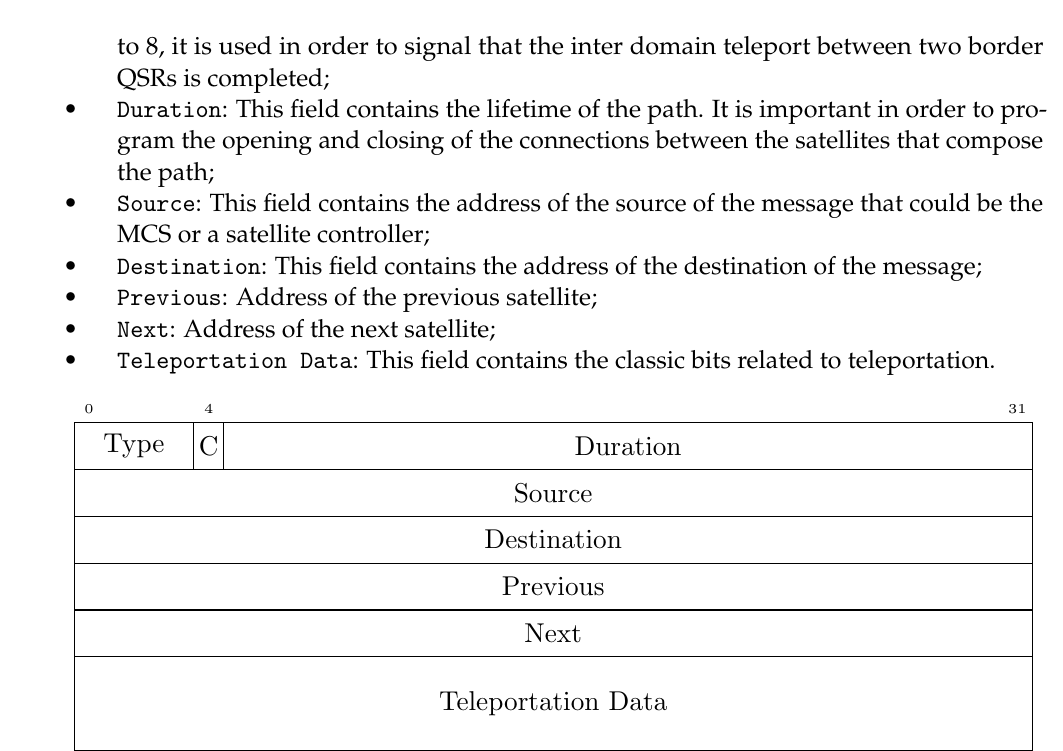
Figure 3. Packet format used by the protocol designed for the proposed